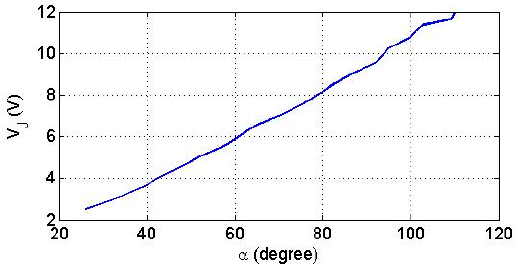
Figure 6. The function (cid:1848) (cid:3011) ( α ) generated by the angle sensor.